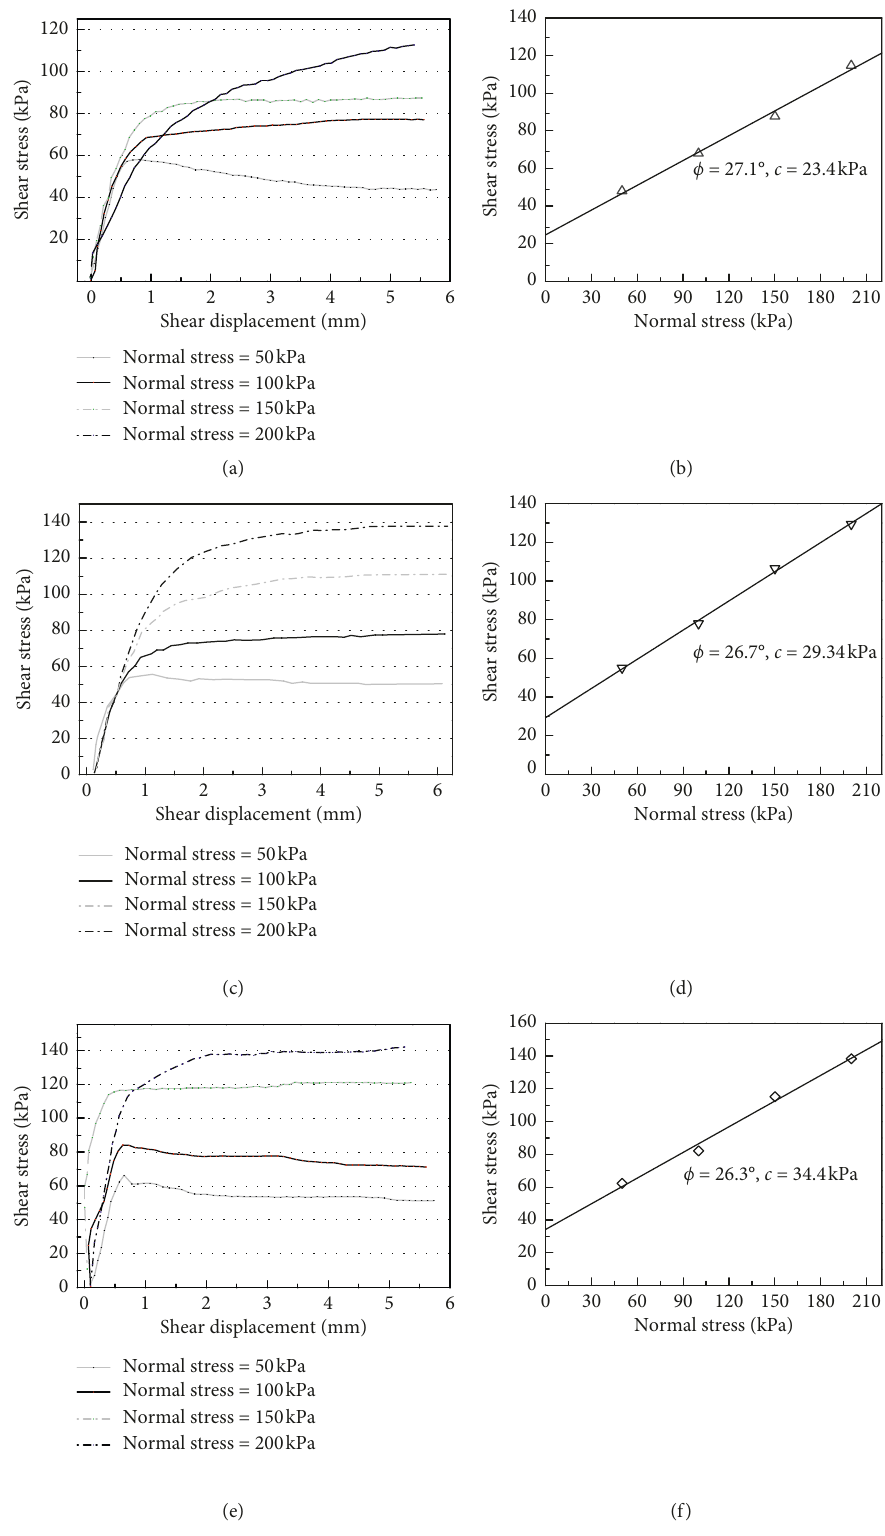
Figure 6: Stress-displacement curve for direction shear test on specimen with different sampling directions. (a) Stress-displacement curve for sample of 0 ° , (b) peak shear strength envelopes for sample of 0 ° , (c) stress-displacement curve for sample of 45 ° , (d) peak shear strength envelopes for sample of 45 ° , (e) stress-displacement curve for sample of 90 ° , and (f) peak shear strength envelopes for sample of 90 °